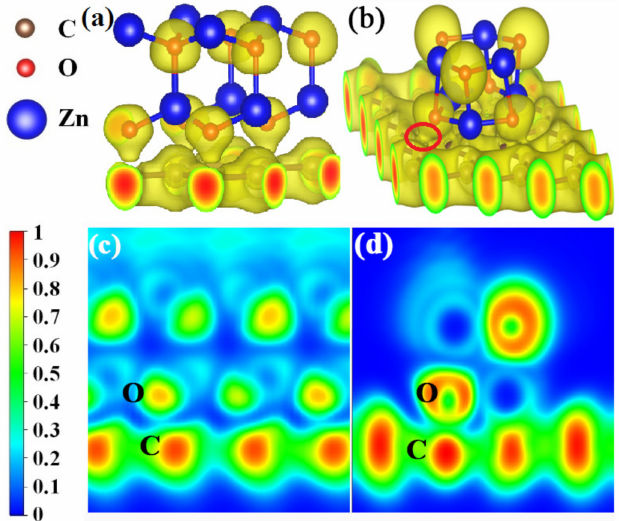
Figure 8. ( a , b ) Three-dimensional local electron density distributions with isosurface plots of the ZnO/graphene interface; yellow regions indicate accumulation of electrons. The isosurface plots (with a value of 0.45 eV/bohr 3 ) clearly illustrate the electron distribution localized around O atoms. ( c , d ) The two-dimensional electron localization function for the ZnO/graphene interface. Blue regions are domains of low electron localization, while red regions are domains of high electron localization. ELF values of 0 and 1 correspond to perfect delocalization and localization,